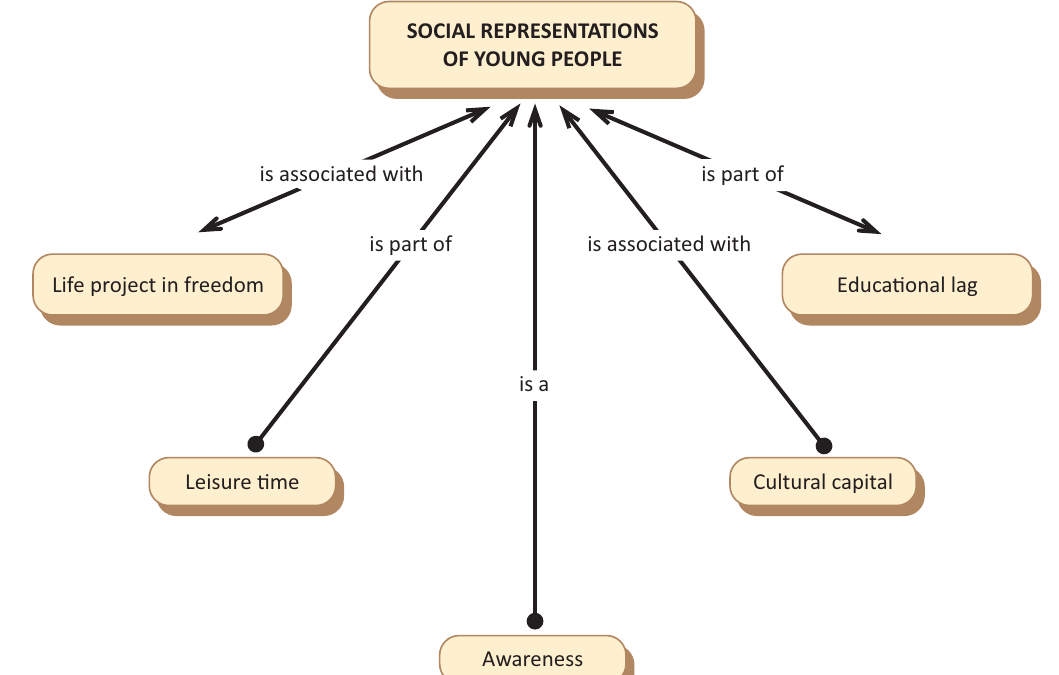
Figure 1. Network, social representations of the process of reintegration in imprisonment in La Araucanía. Analysis net‐ work built with Atlas.ti 8.0